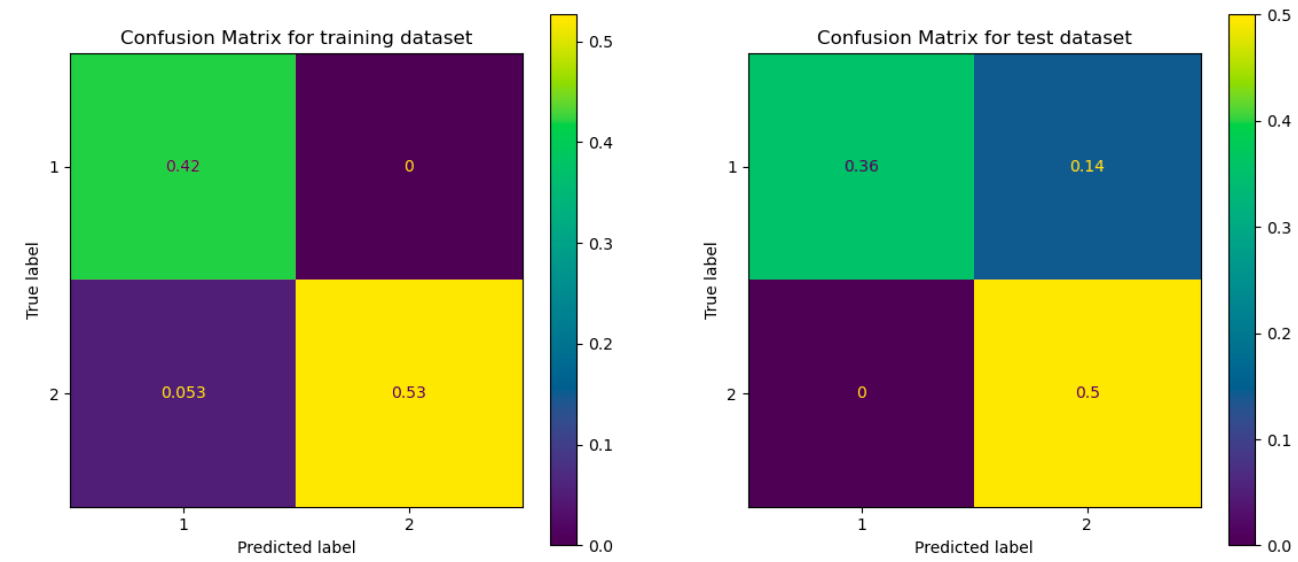
Figure 4. Confusion matrix of the training group (at the ( left )) and the test group (at the ( right )).